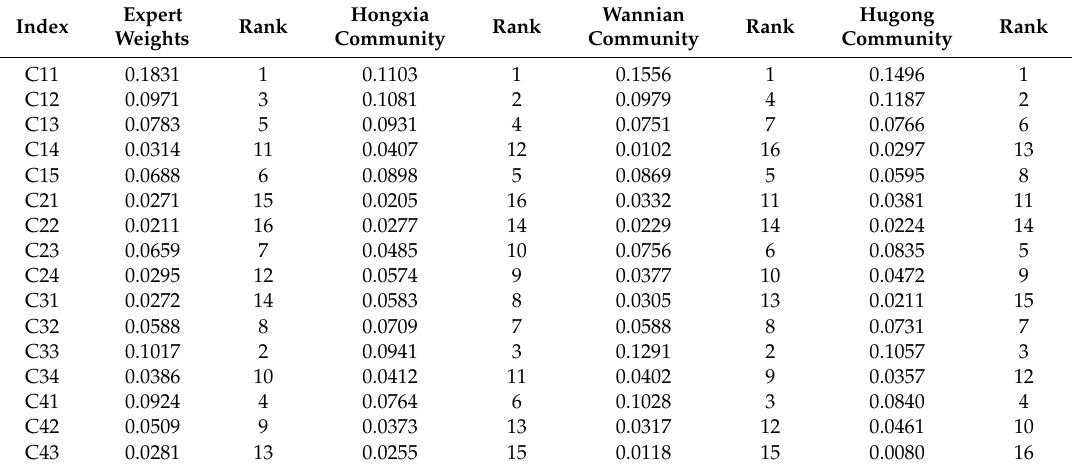
Table 3. Comparison of weights of each model